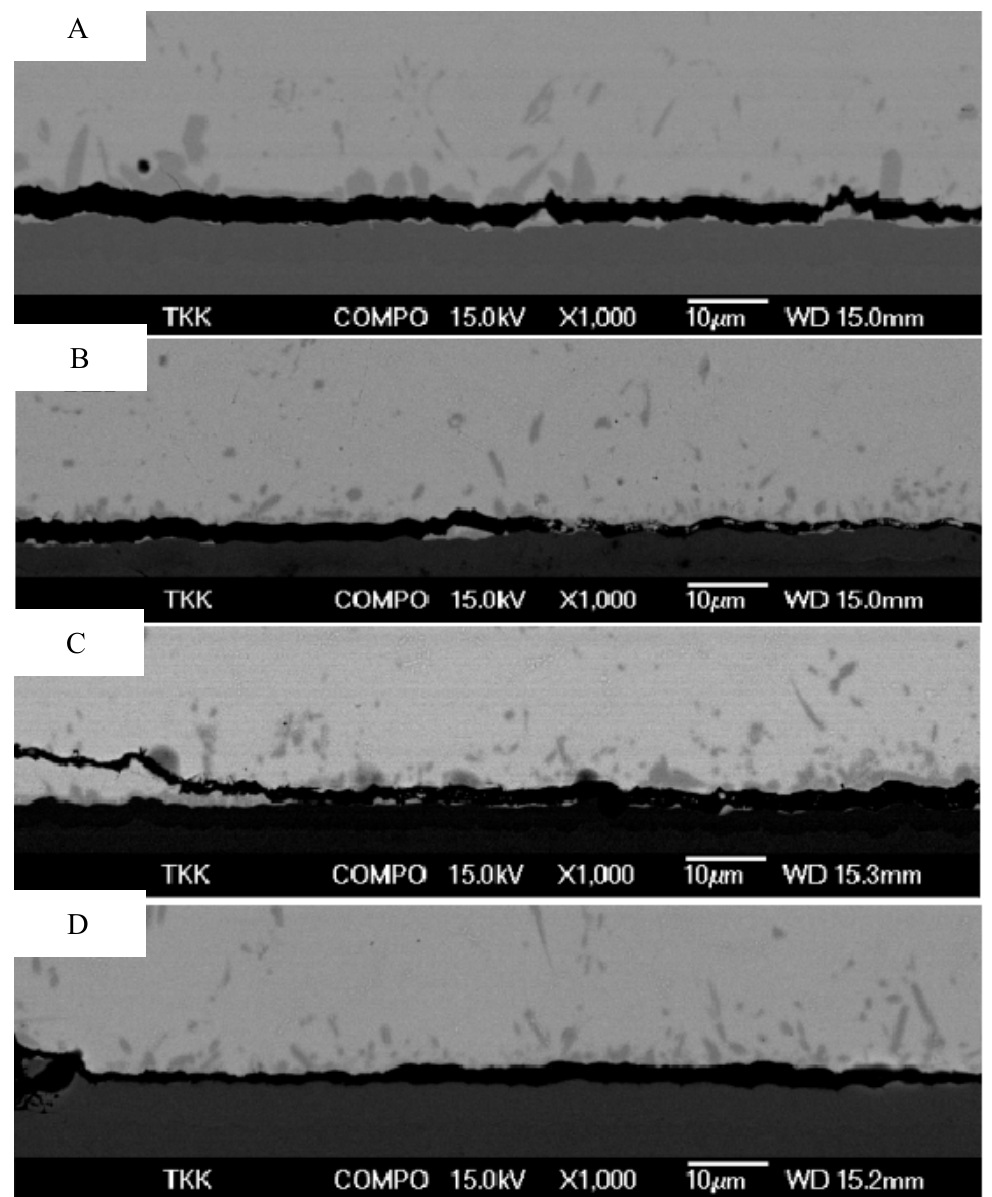
Figure 2. Failure mechanisms related to the different phosphorus